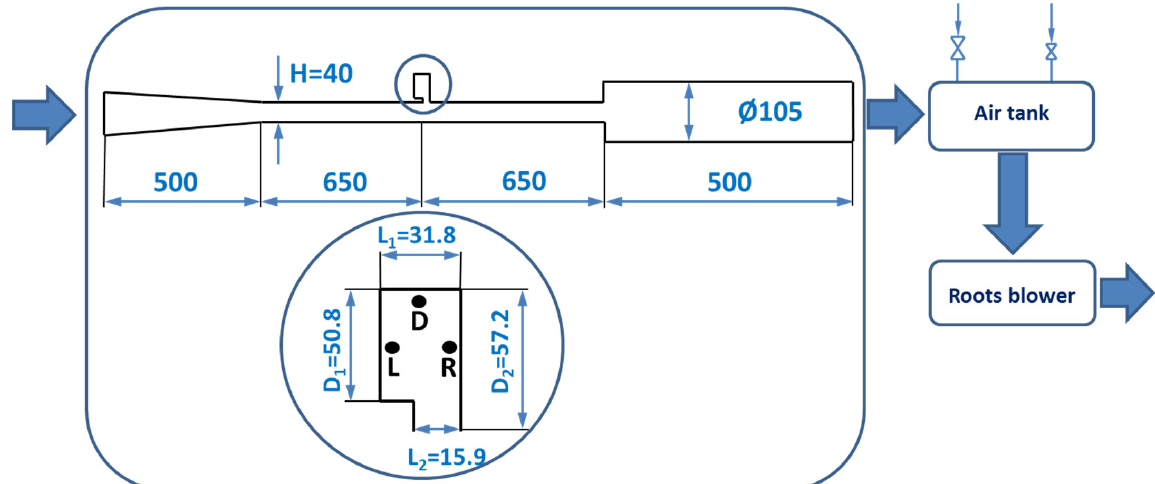
Figure 2. Scheme of the test stand and the air preparation system.